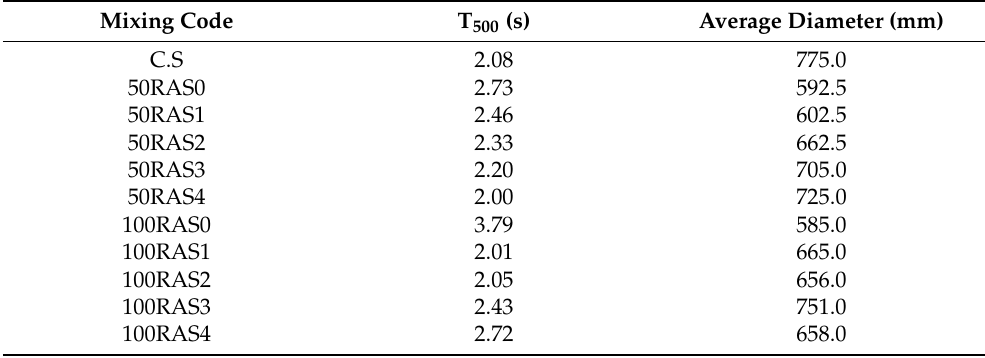
Table 4. The results of the Slump flow